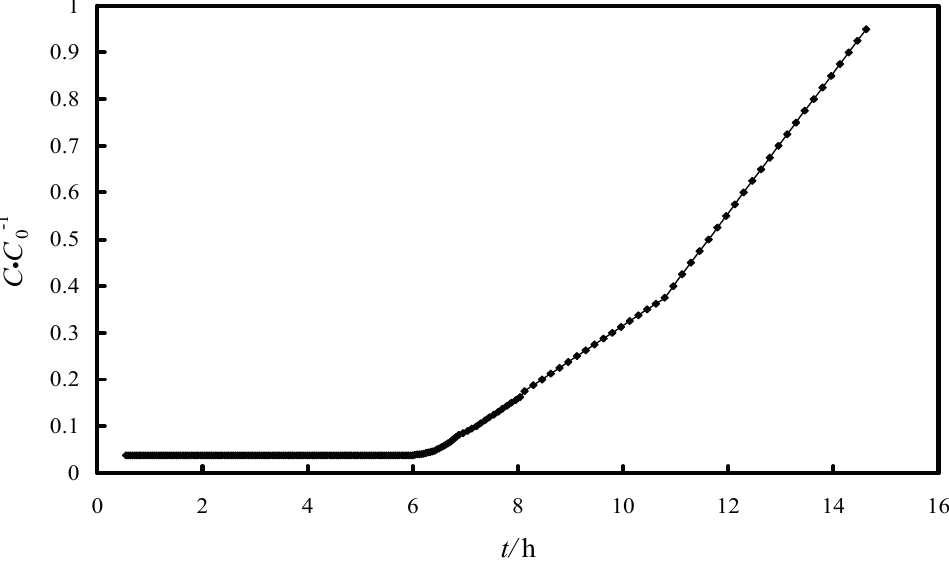
Figure 12. Breakthrough curve for arsenic using Fe-XAD8-DEHPA.